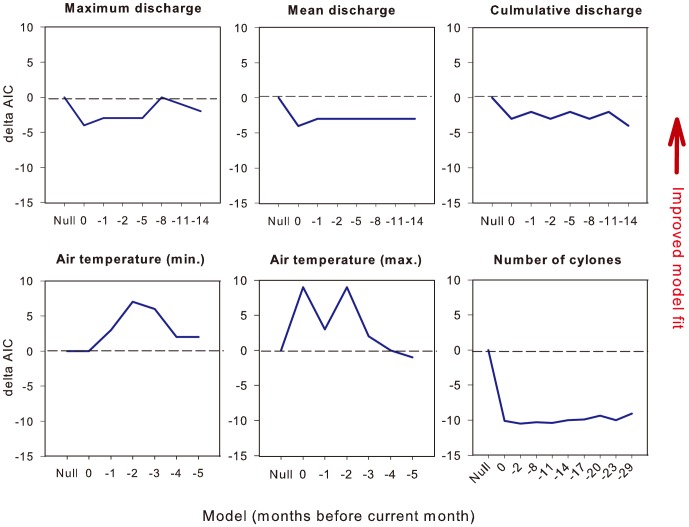
Fit of different additive models of offshore/migratory cetacean natural mortality as a function of environmental predictors at lags from zero (same month) up to 29 months (-29).Refer to the caption of Figure 3 for a full explanation.